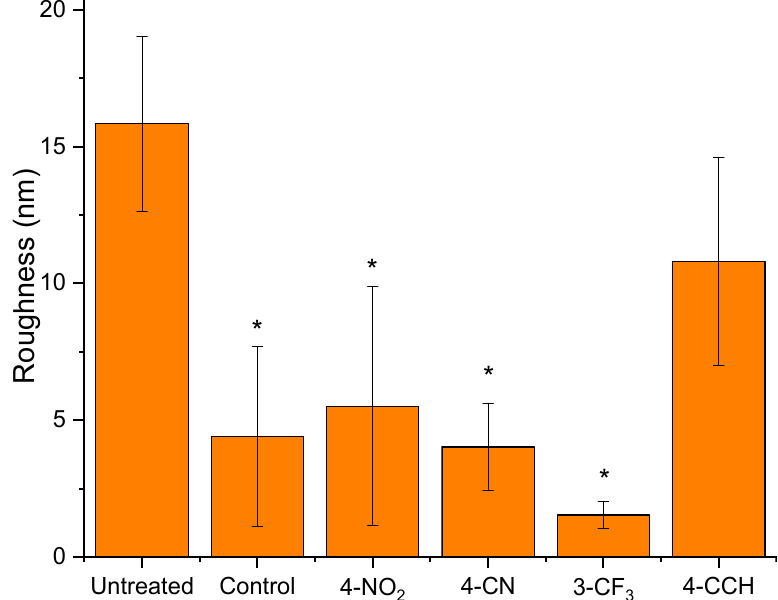
Figure 4. Roughness of modified silk ( R a ) membranes determined by atomic force microscopy (AFM). Errors are standard deviation, *denotes statistically significant difference to untreated sample, P < 0.05.